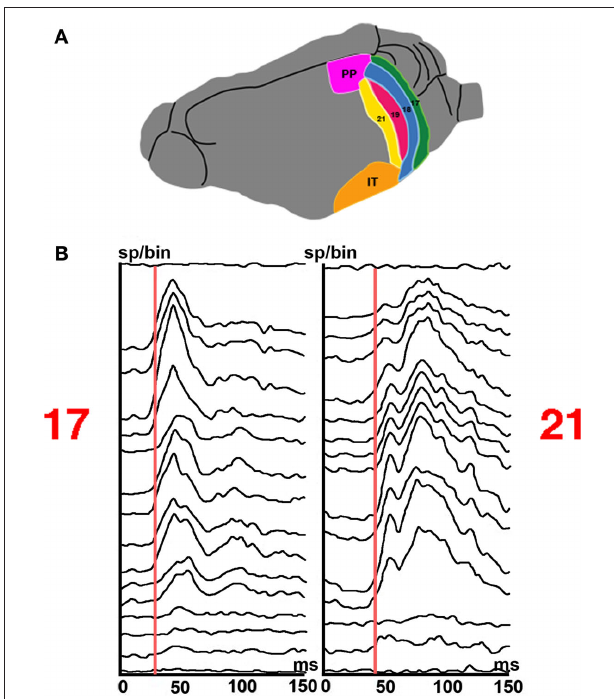
Figure 9 | Laminar firing at the mapping sites in area 17 and 21 of a stationary square appearing at 0 ms. (A) Six visual areas of the ferret. (B) Post stimulus histogram from 16 leads. Note the difference in latencies between laminae and the longer latencies to peak in area 21. Note also the larger amplitude of the r(t) and earlier peak to the FB from higher order areas at 80 ms in area 21 compared to the second peak in area 17 (100